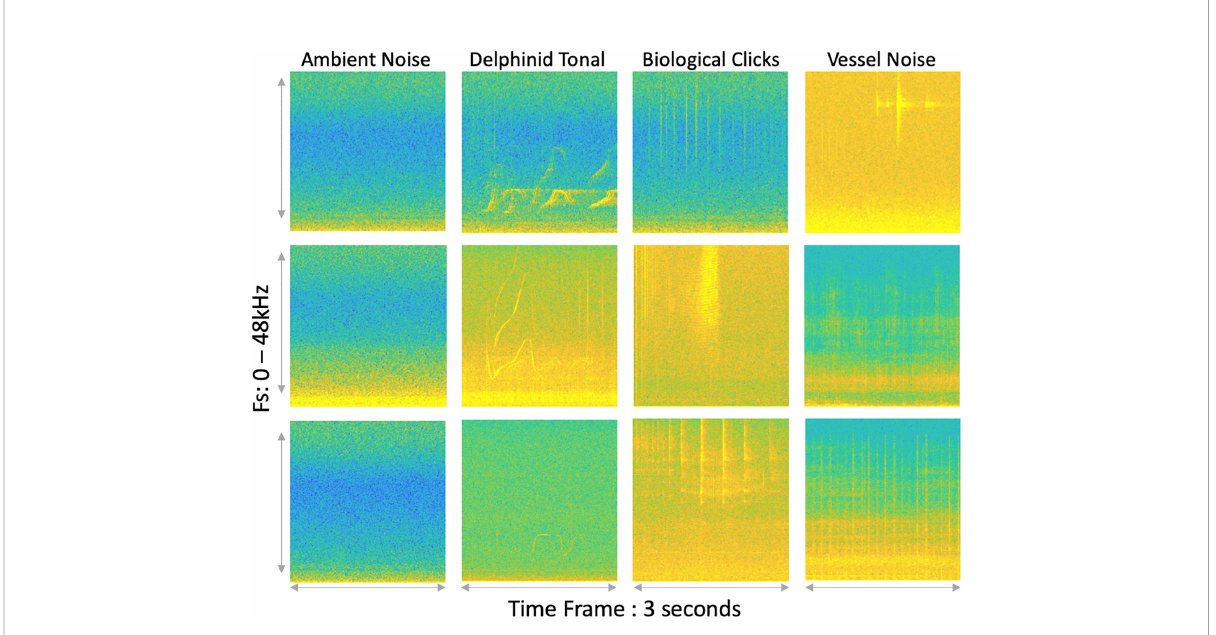
FIGURE 3 Representative spectrograms illustrating the four classes used as input for training; Ambient noise, Delphinid tonal, Biological clicks (echolocation and burst pulses) and Vessel noise. Each spectrogram had an image resolution of 224x224 pixels and is computed using a Hanning window, 75% overlap, and an FFT size of 2048, standardised across the various sampling rates. Time and Frequency are on the horizontal and vertical axes, respectively. Three different examples are shown for each sound class as spectrogram characteristics vary across temporal, spatial and geographic scales introducing variance during training, essential for generalisation to new unseen